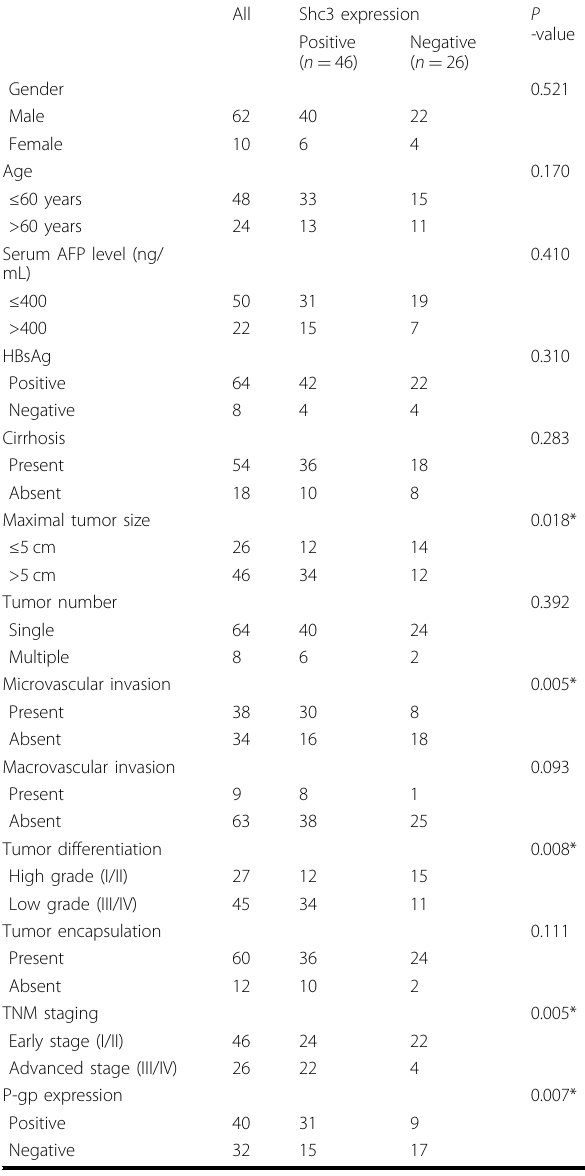
Table 1 Clinicopathological information of hepatocellular carcinoma